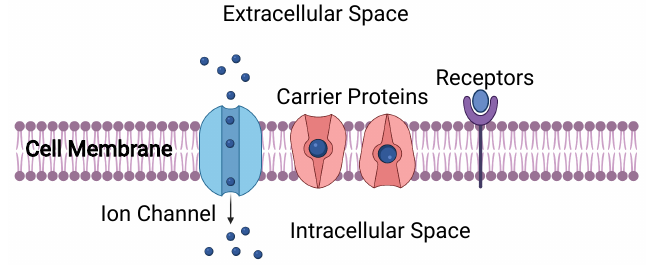
Figure 1. Schematic of the cell membrane and membrane proteins such as ion channels, carrier proteins, and receptors. Cells interact with the external environment via membrane